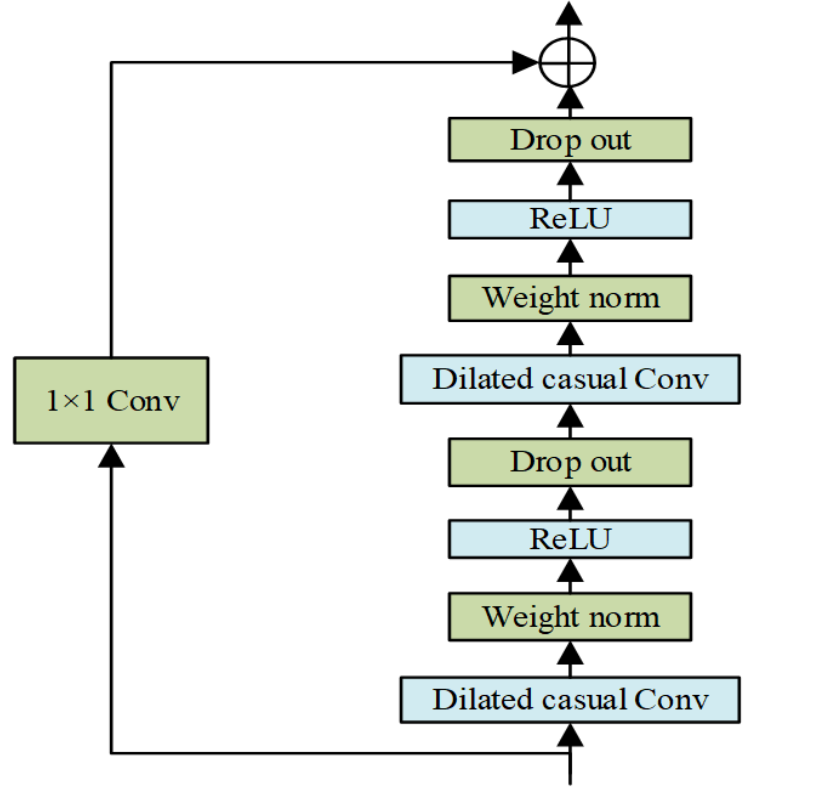
Figure 2. Structure diagram of the residual link module.